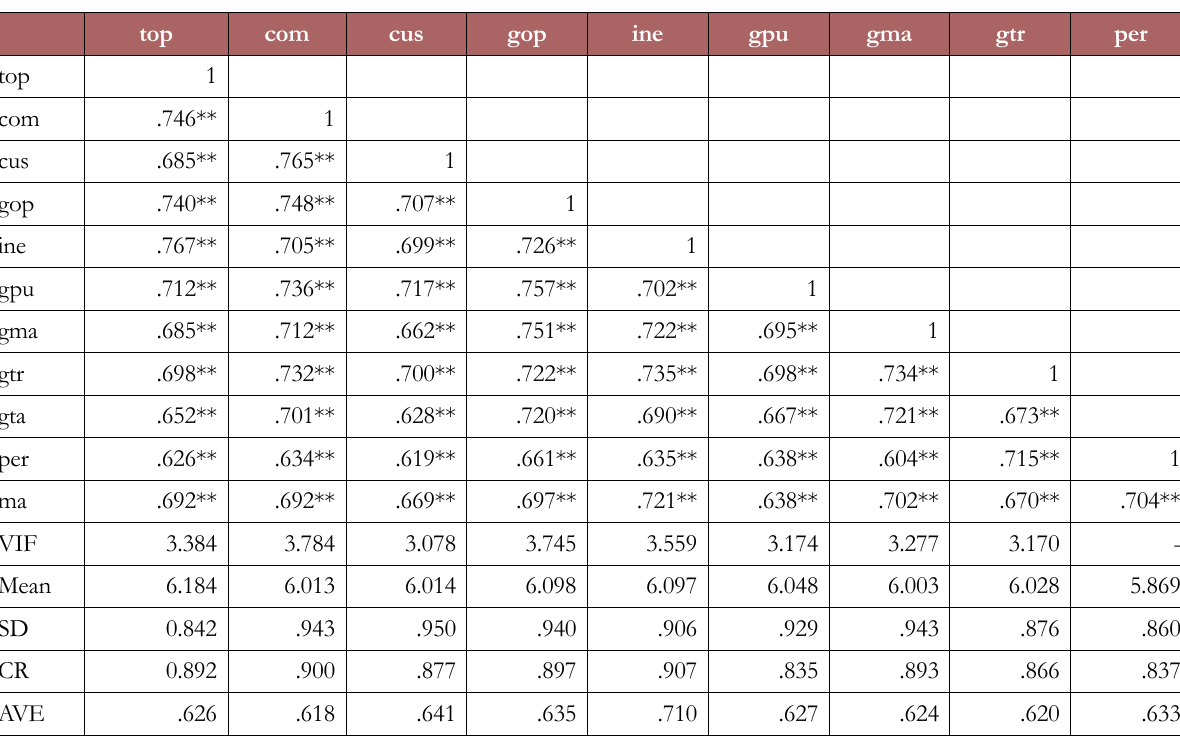
Table 1. Correlations of the Variable and Descriptive Validity